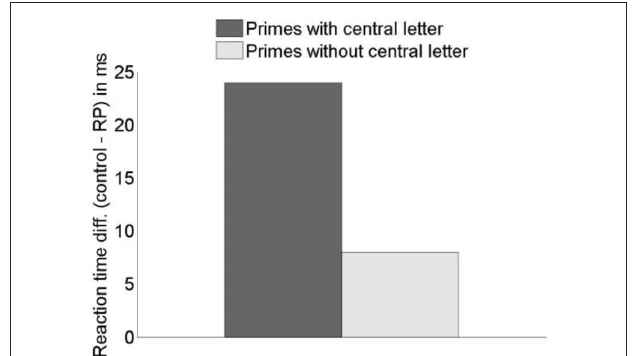
Figure 6 | empirical results (priming effect sizes measured as rT differences) in human participants for the effect of central letters on priming.